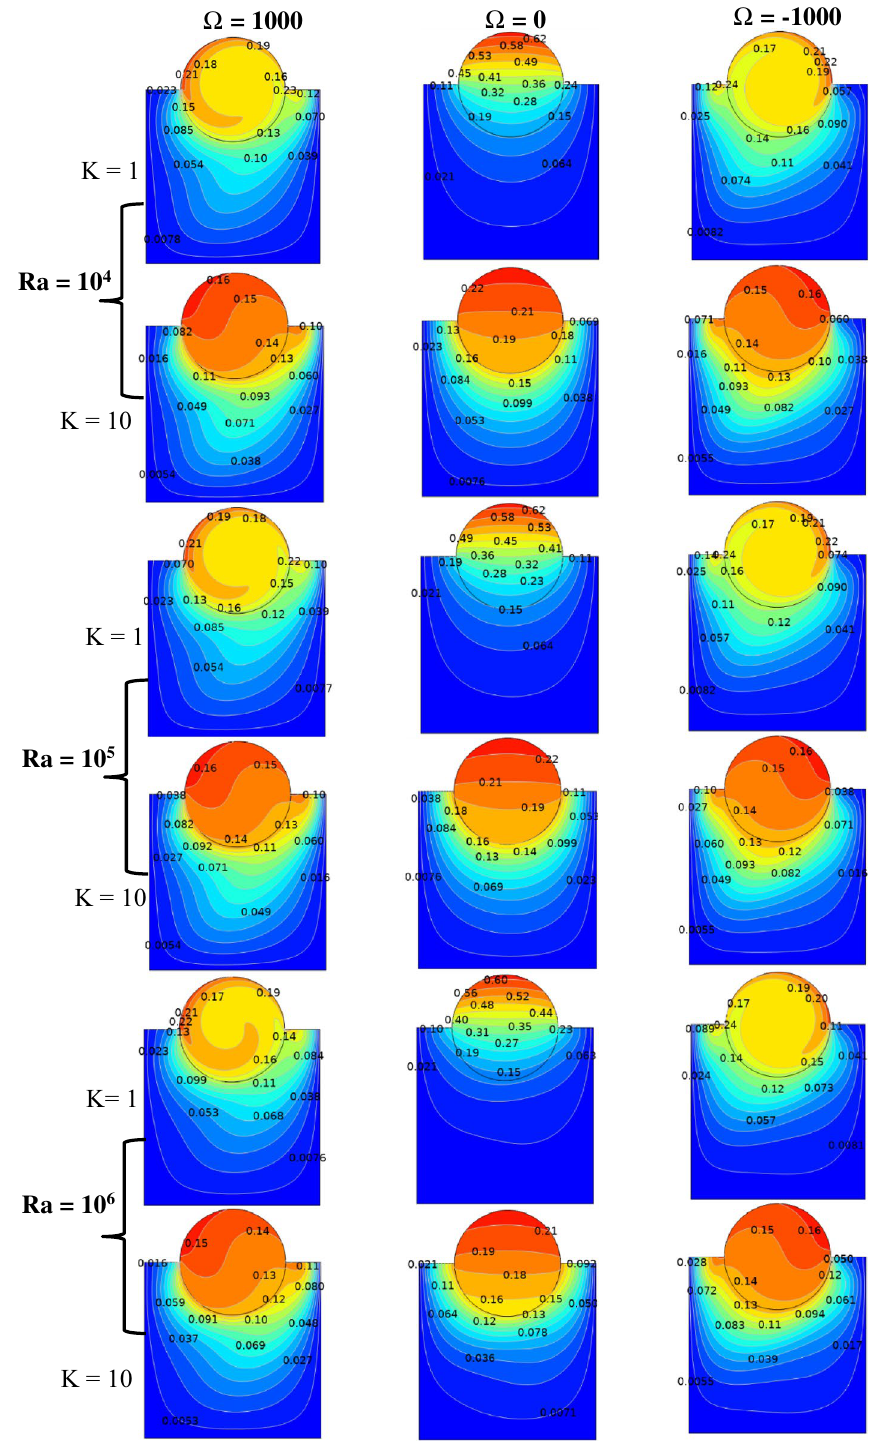
Figure 6. Isotherms for different Rayleigh numbers, dimensionless rotating angular velocities, and thermal conductivity ratios at Ha = 60, λ = 0.52, = 0.05, and γ = ϕ